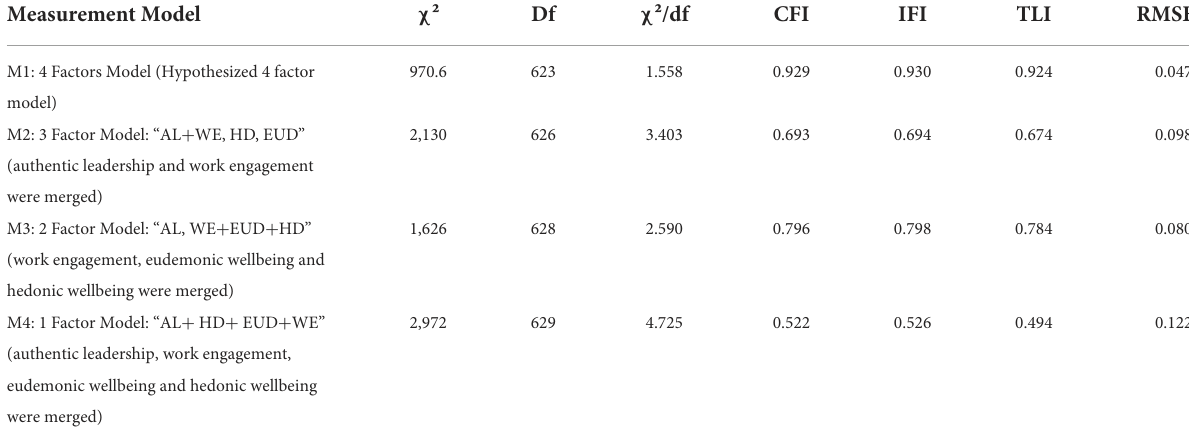
TABLE 2 Confirmatory factor analysis and alternative measurement models.